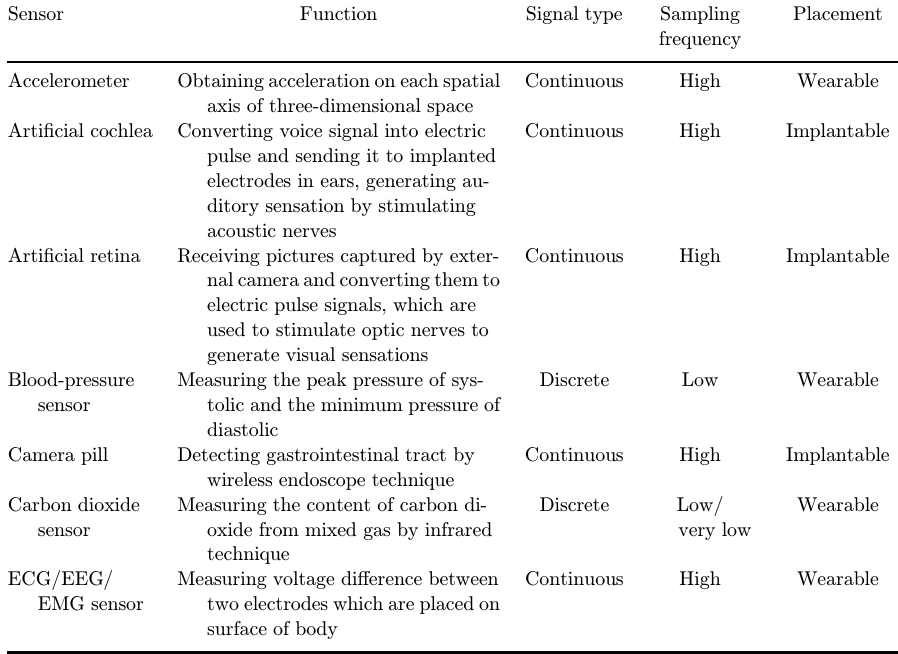
Table 3. Commonly used sensors in body sensor networks.